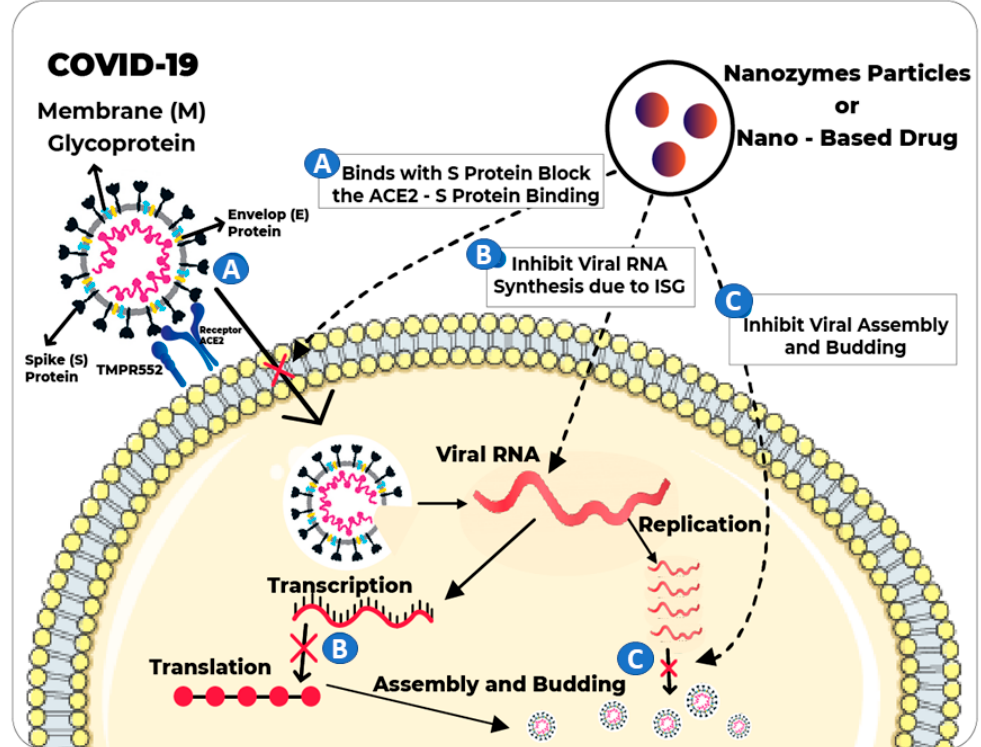
Figure 3. Possible mechanism of virus inactivation: ( A ) by blocking the viral entry, ( B ) by inhibiting viral RNA synthesis, ( C ) by blocking viral assembly and proliferation.